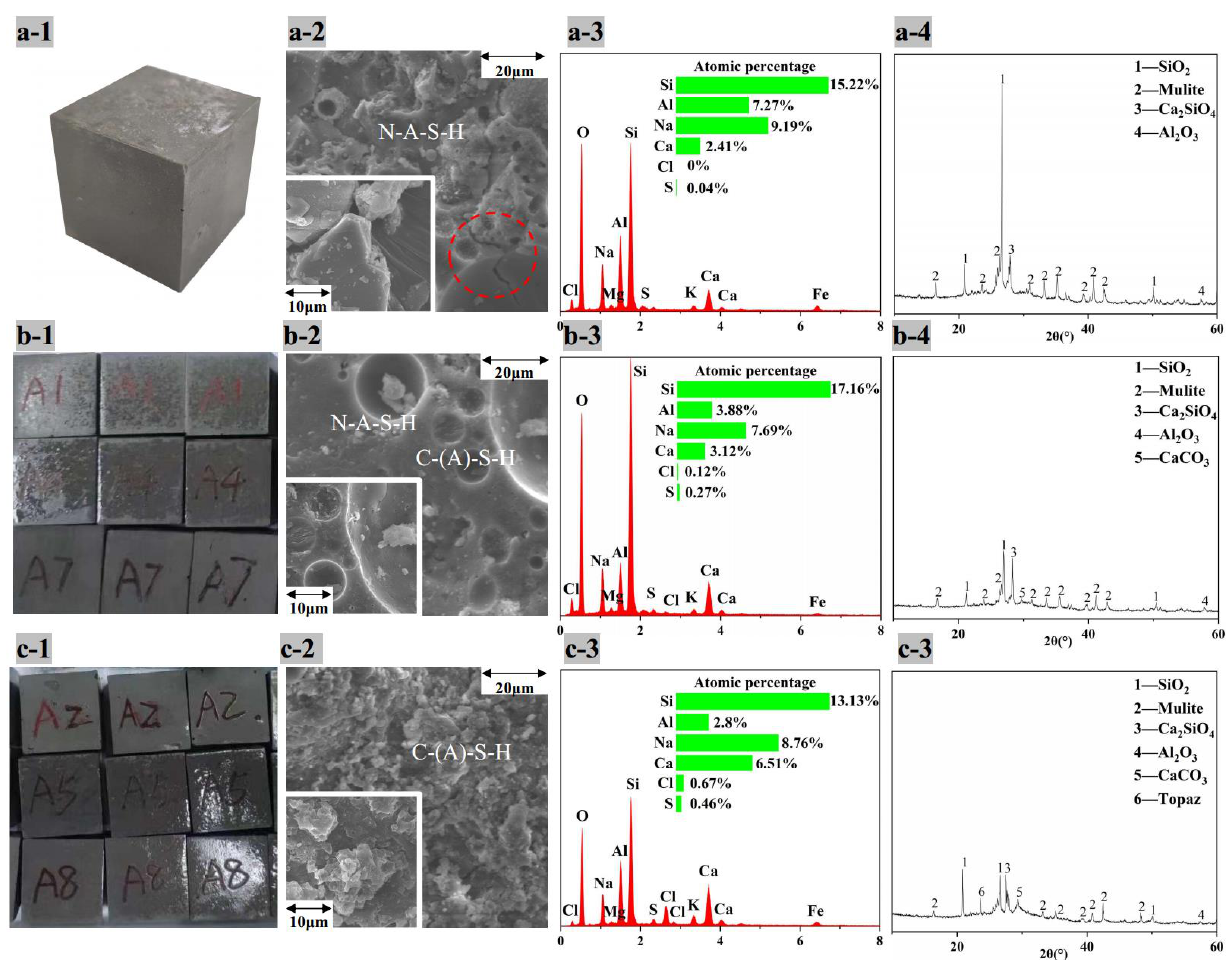
Figure 9. Appearance, micromorphology and elements distribution of surface and XRD patterns of AACM blocks (28 days). ( a )PC1, ( b ) PSM1 and ( c ) PSM3. AACM blocks (28 days). ( a ) PC1, ( b ) PSM1 and ( c )